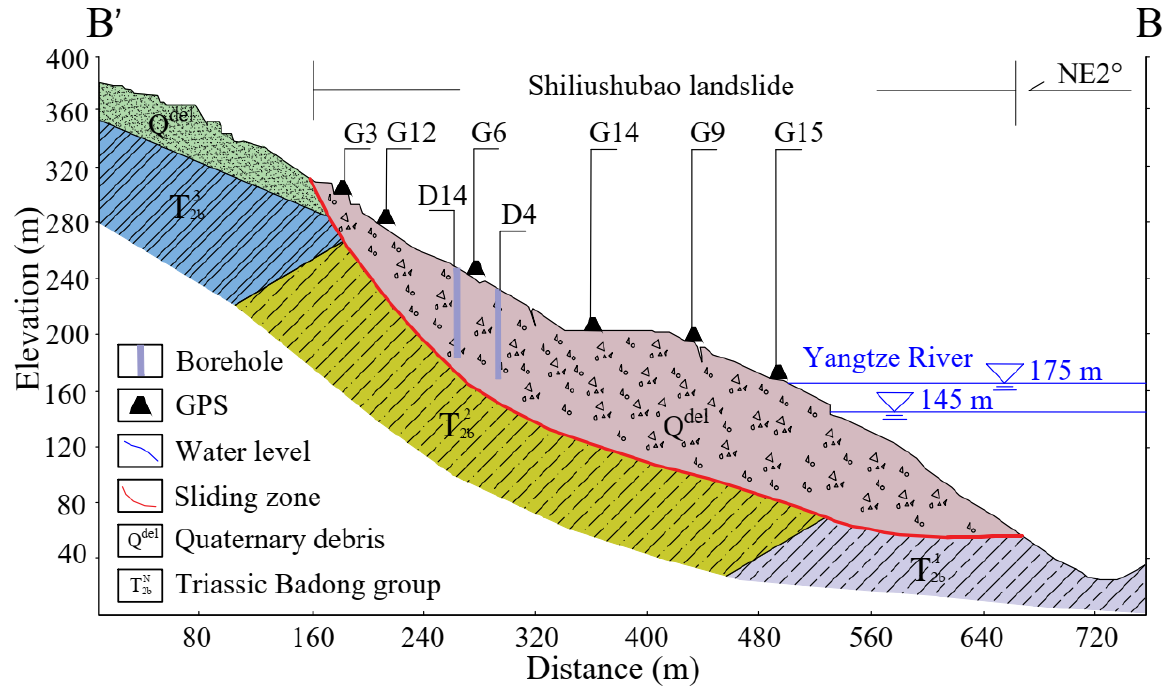
Figure 4. Geological section of the Shiliushubao landslide (B-B’).